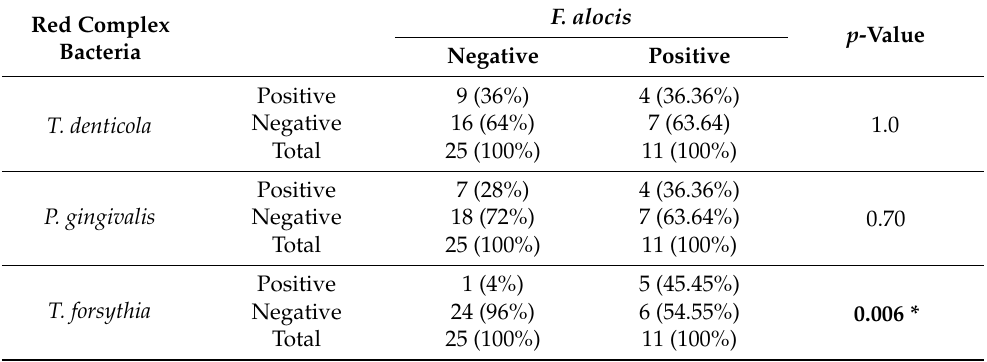
Fisher’s exact Test, * p < 0.05 =